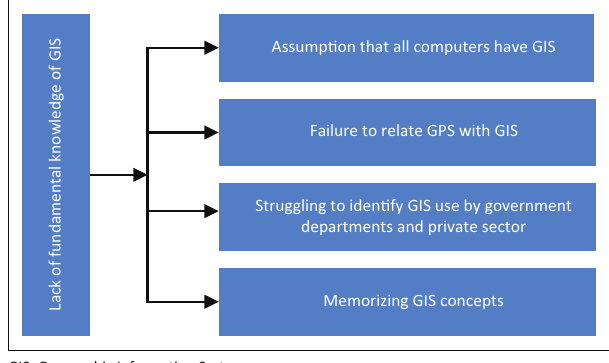
FIGURE 1: Themes on lack of fundamental knowledge of Geographic Information